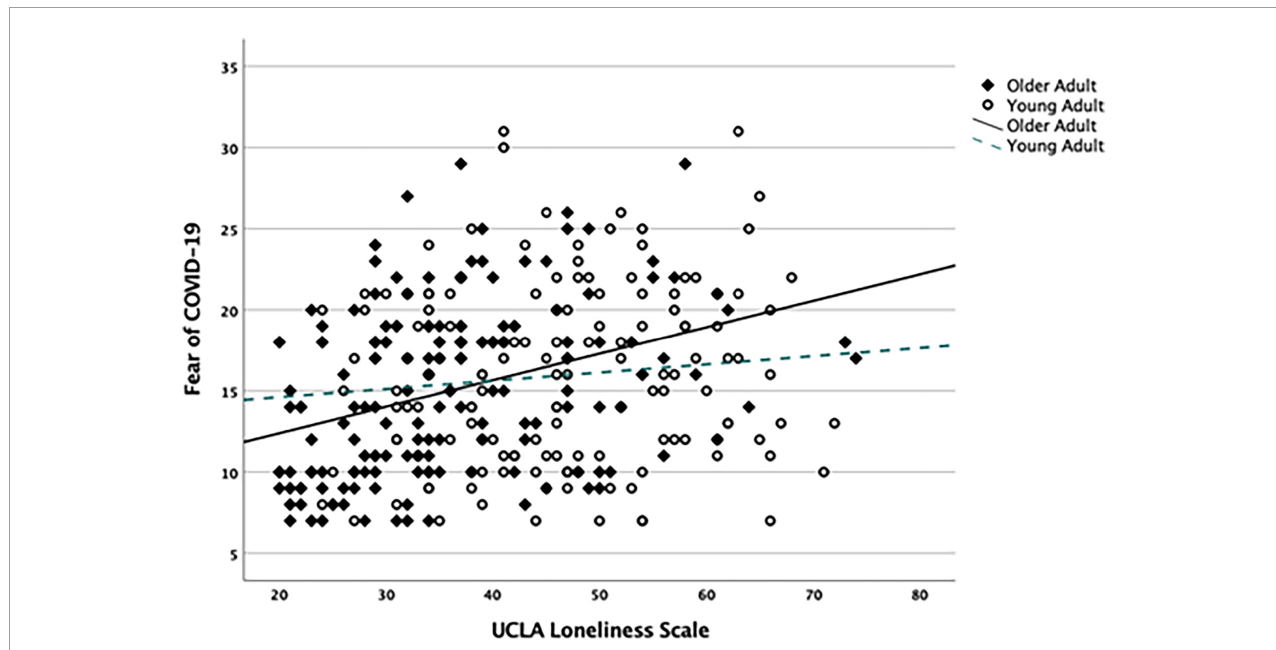
FIGURE1 Moderating effects of age group on the relationship between fear of COVID-19 and